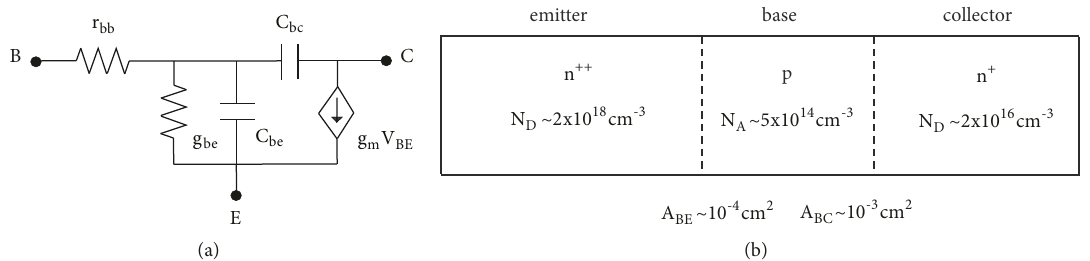
Figure 2: (a) Equivalent-circuit approximation for high frequencies. (b) Junction transistor model. Representative impurities concentration and cross-sectional areas are